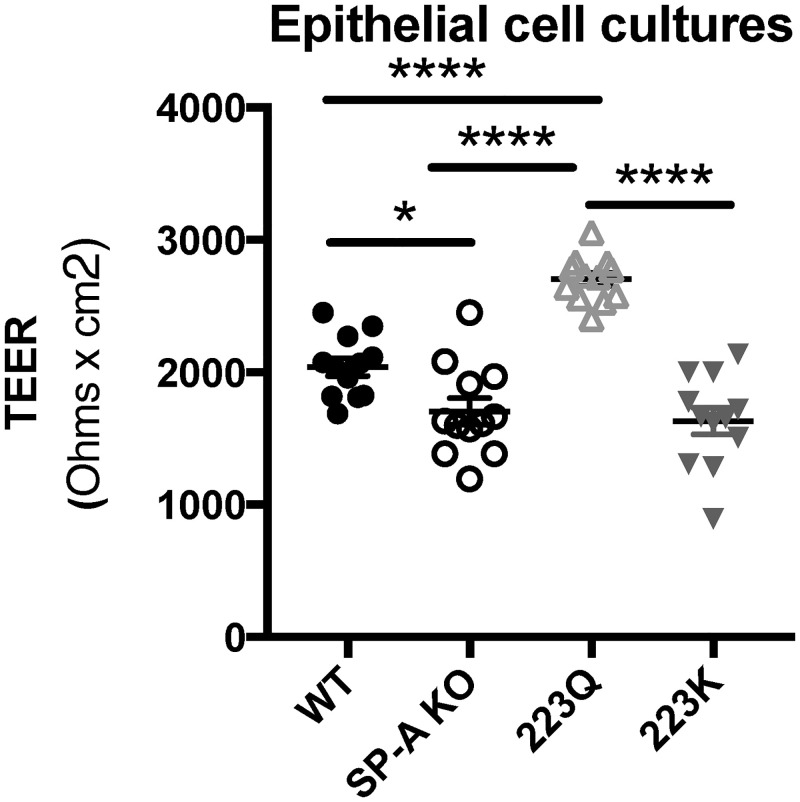
Genetic differences in SP-A2 may impact epithelial cell integrity.Trans-epithelial electrical resistance (TEER) levels of naive mouse tracheal epithelial cells (MTECS). n = 2 experimental repeats combined for total of 12 wells per genotype. Statistical analysis by One-way ANOVA: SP-A 223Q vs. WT, SP-AKO, & SP-A223K ***p < 0.0001. WT vs. SP-A KO *p < 0.05, WT vs SP-A 223K **p < 0.01.